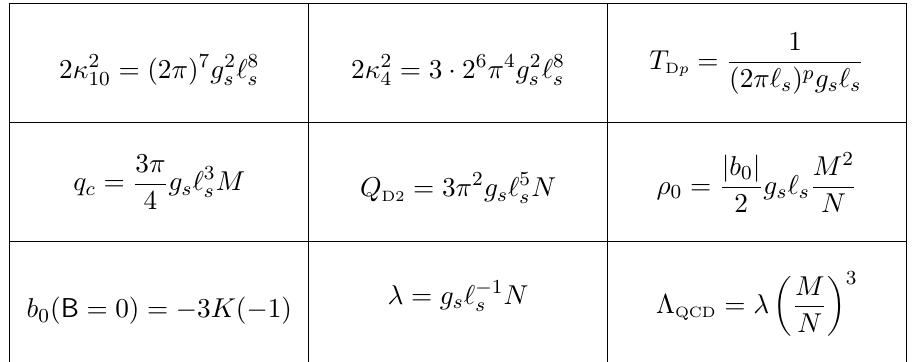
Table 1. Dictionary between gravity and field theory parameters. N and M determine the rank of the gauge groups, λ is the ’t Hooft coupling and Λ the characteristic scale of confinement. QCD On the gravity side q c is the F 4 flux in the internal space, Q is the coefficient of the warp factor D2 when the geometry asymptotes to that of color D2-branes, ρ 0 determines the radial position where the two-cycle in the geometry collapses to zero size and b 0 is a numerical integration constant determined by the equations of motion and regularity. The remaining g s and ‘ s are the string coupling and length, κ 2 and κ 2 are the gravitational constants in the ten- and four-dimensional 10 4 theories respectively, and T is the D p -brane D p